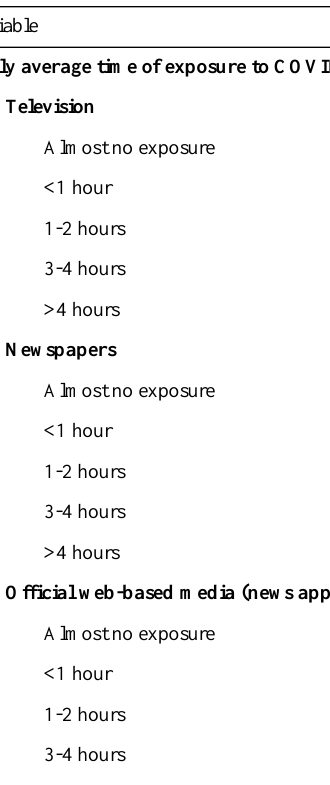
Table 4. Responses to items measuring interpersonal-level variables